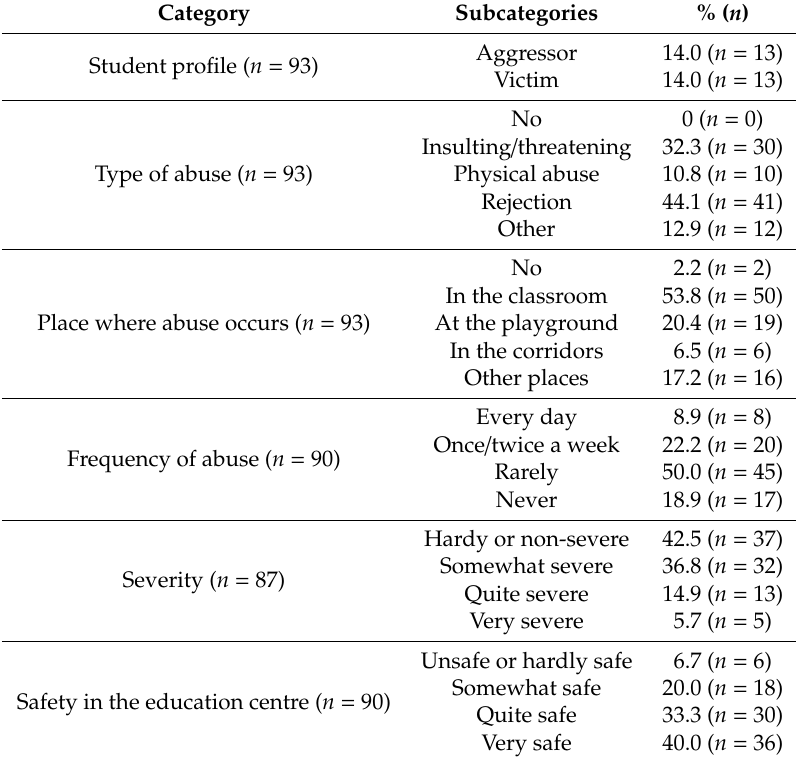
Table 1. Descriptive data on the phenomenon of